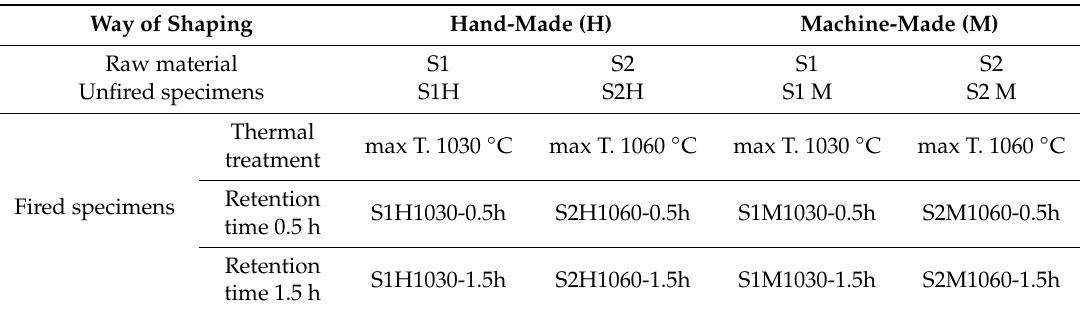
Table 5. Used raw materials, way of shaping, maximal firing temperature and retention time at the maximal temperature.